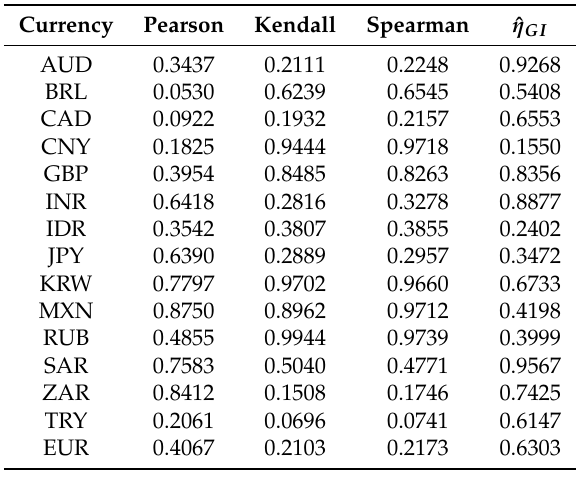
Table 4. The p -values of correlation tests between the standardized residuals of ARS and those of the other 15 currencies based on Pearson’s product moment correlation coefficient, Kendall’s τ and Spearman’s ρ , respectively. The last column contains the p -values of the test of H 0 using the OLS test